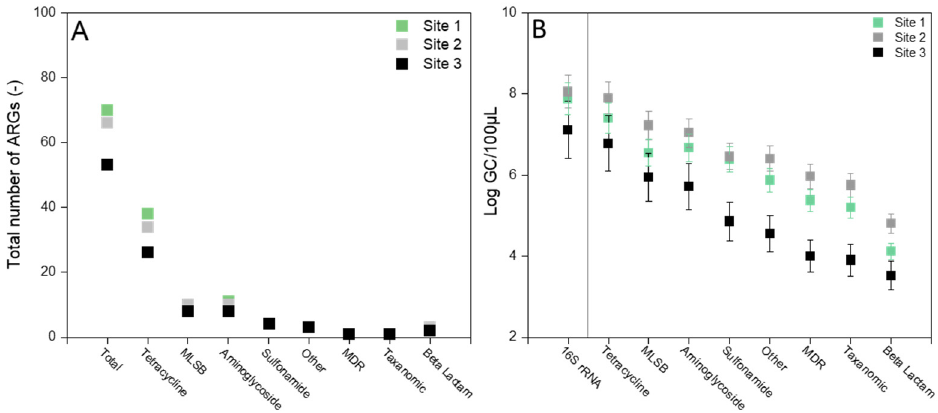
Figure 1. Comparison of ( A ) total detected ARGs and ( B ) log value of ARG copy numbers among three sampling sites, conferring resistance to different antibiotics, where GC referred to gene copy numbers.